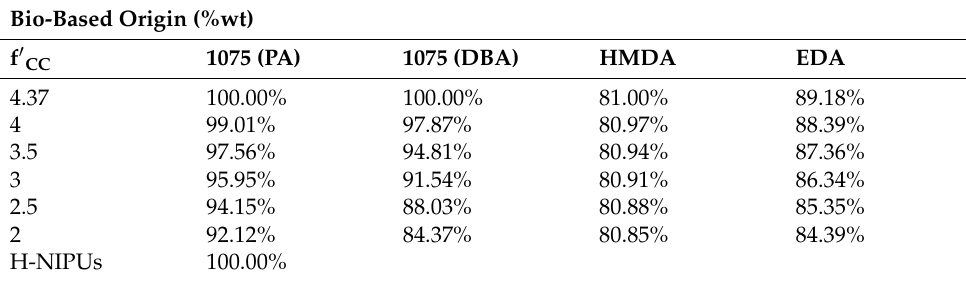
Table 2. Bio-based NIPU raw material content